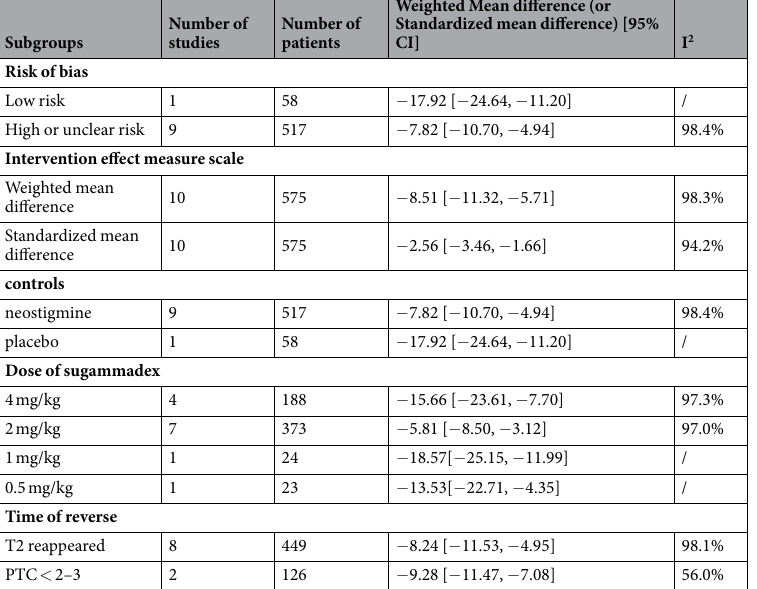
Table 3. Subgroup analysis and sensitivity